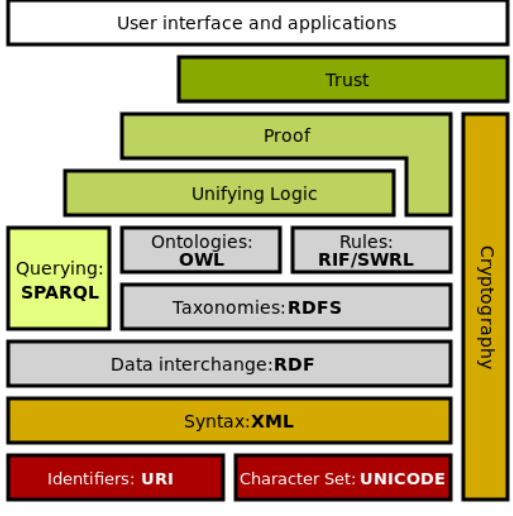
Figure 1. The Semantic Web